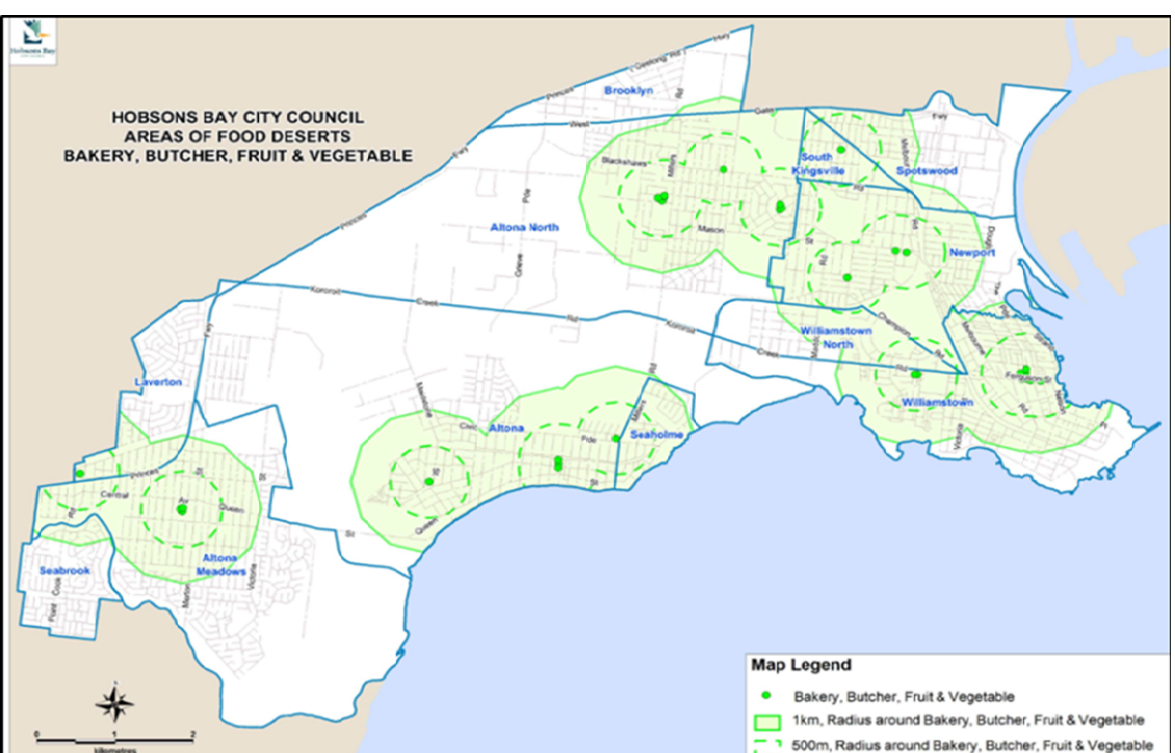
Figure 1. Depiction of Food Desert Areas in City of Hobsons